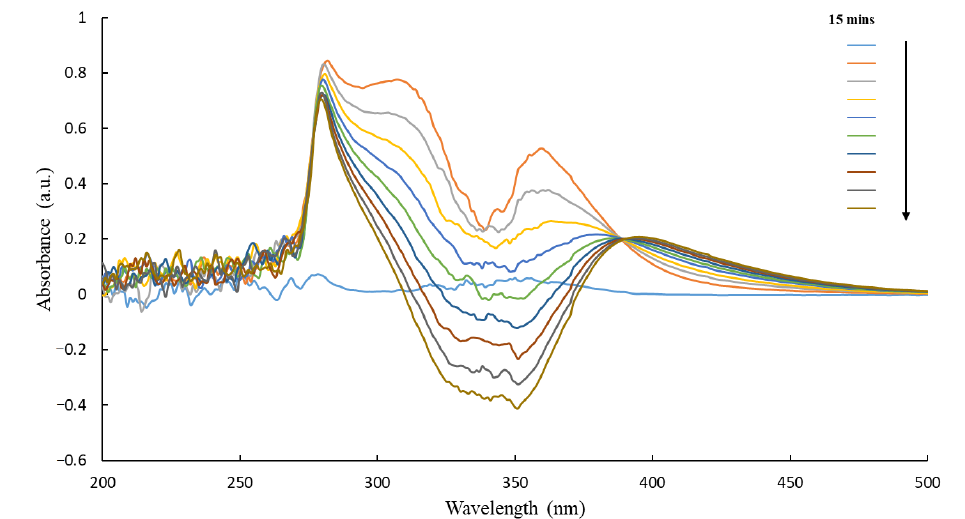
Figure 5. UV-Vis spectra of YfkO-cys showing the enzymatic activity assay with increasing time. (1) NTR absorbance ~290 nm. (2) Reduction of CB1954 λ-max = 327 nm. (3) Oxidation of NADH λ- max = 340 nm. (4) Production of CB1954 hydroxylamine derivatives λ-max = 420 nm.